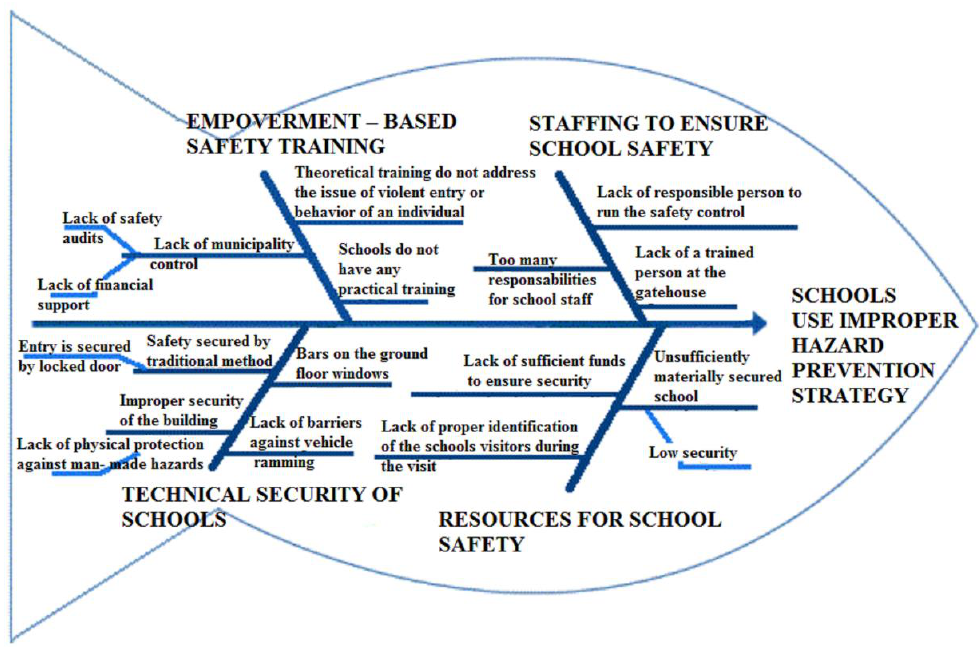
Figure 6. Cause-and-effect diagram for school hazard prevention strategy. Source: own.